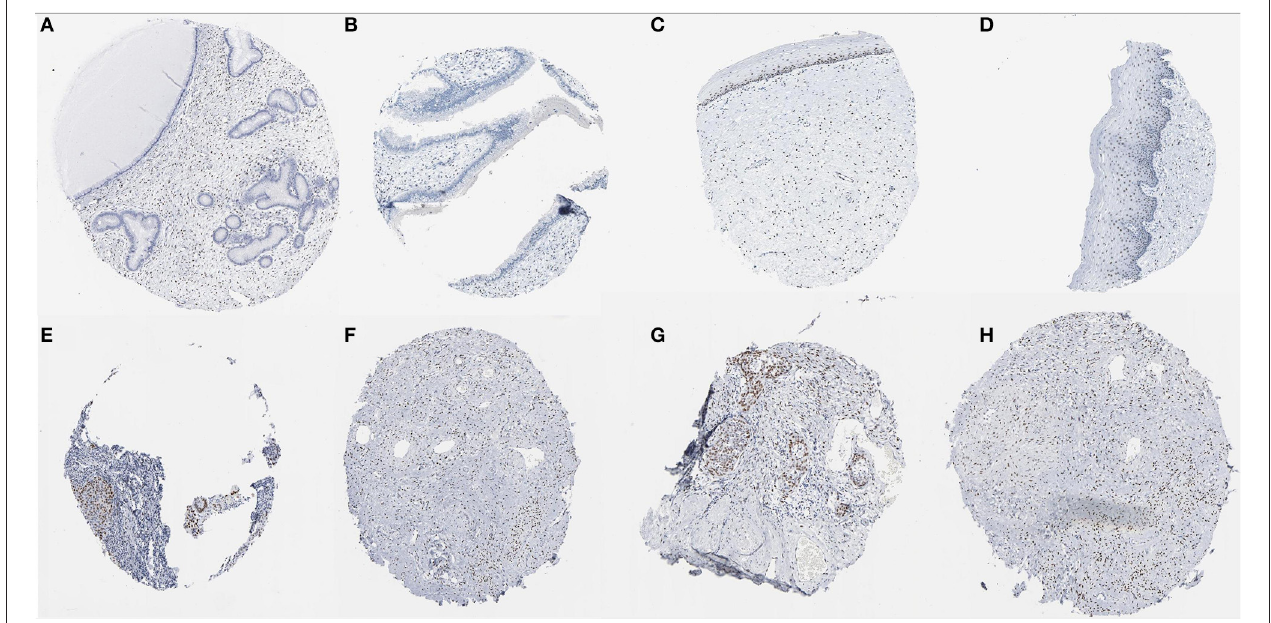
FIGURE 11 | Immunohistochemical images of the JUN gene in cervical tissue. (A–D) Normal cervix JUN protein was not shown in normal cervical tissues; (E–H) JUN protein showed moderate to high levels of staining in CESC (Image available from v21.0. proteinatlas.org).